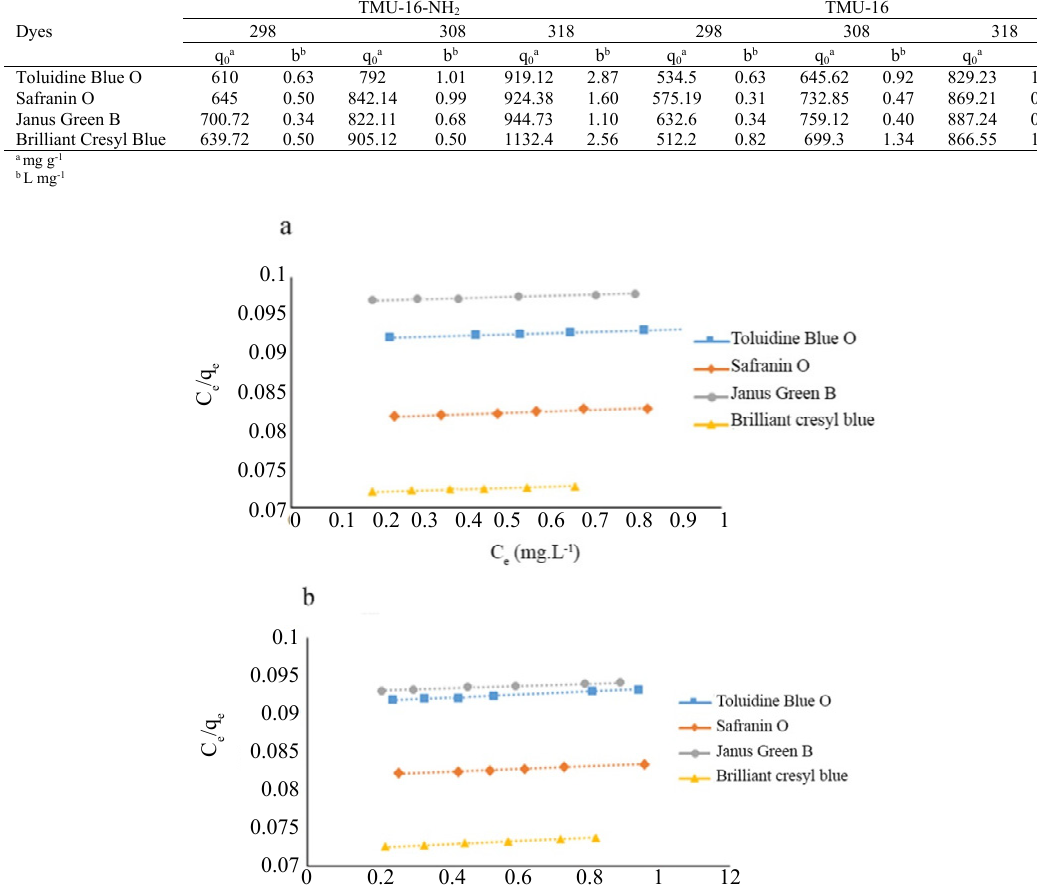
Table 3 Langmuir parameters for the adsorption of dyes over TMU-16 and TMU-16-NH 2 . Dyes